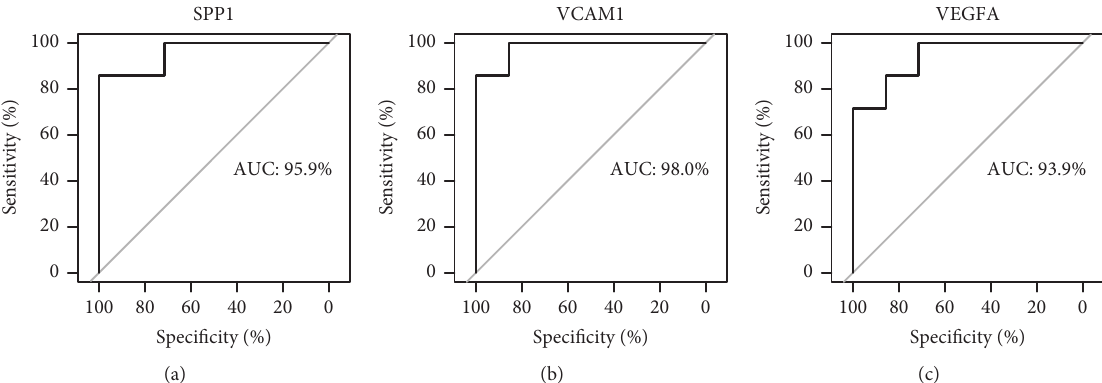
Figure 6: ROC curves of three hub genes with excellent diagnostic value for ACS. The AUC was calculated for each plot. ROC: receiver operating characteristic; AUC: area under